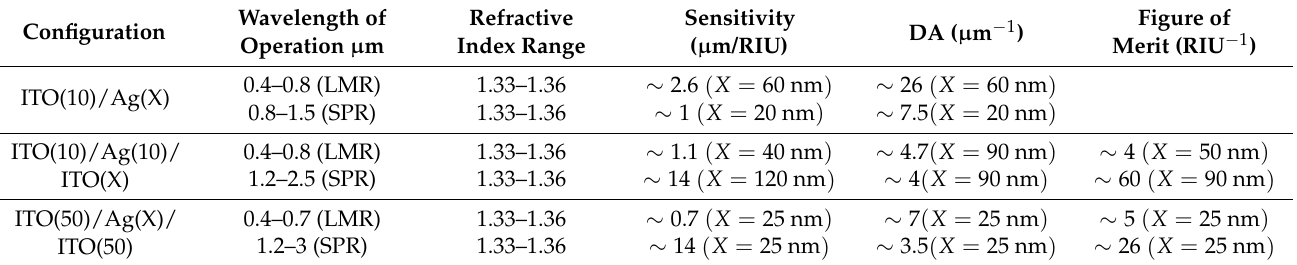
Table 1. Summary of the results obtained in bi layer and tri layer